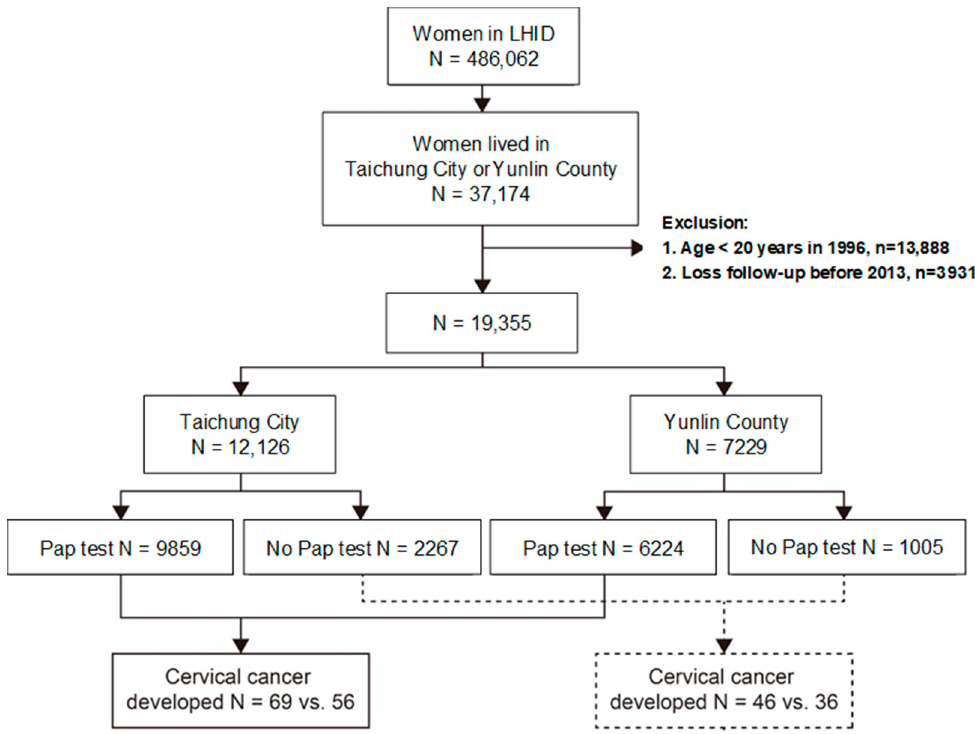
Figure 1. Flow chat for the process to identify the study population from the Longitudinal Health Insurance Database (LHID).